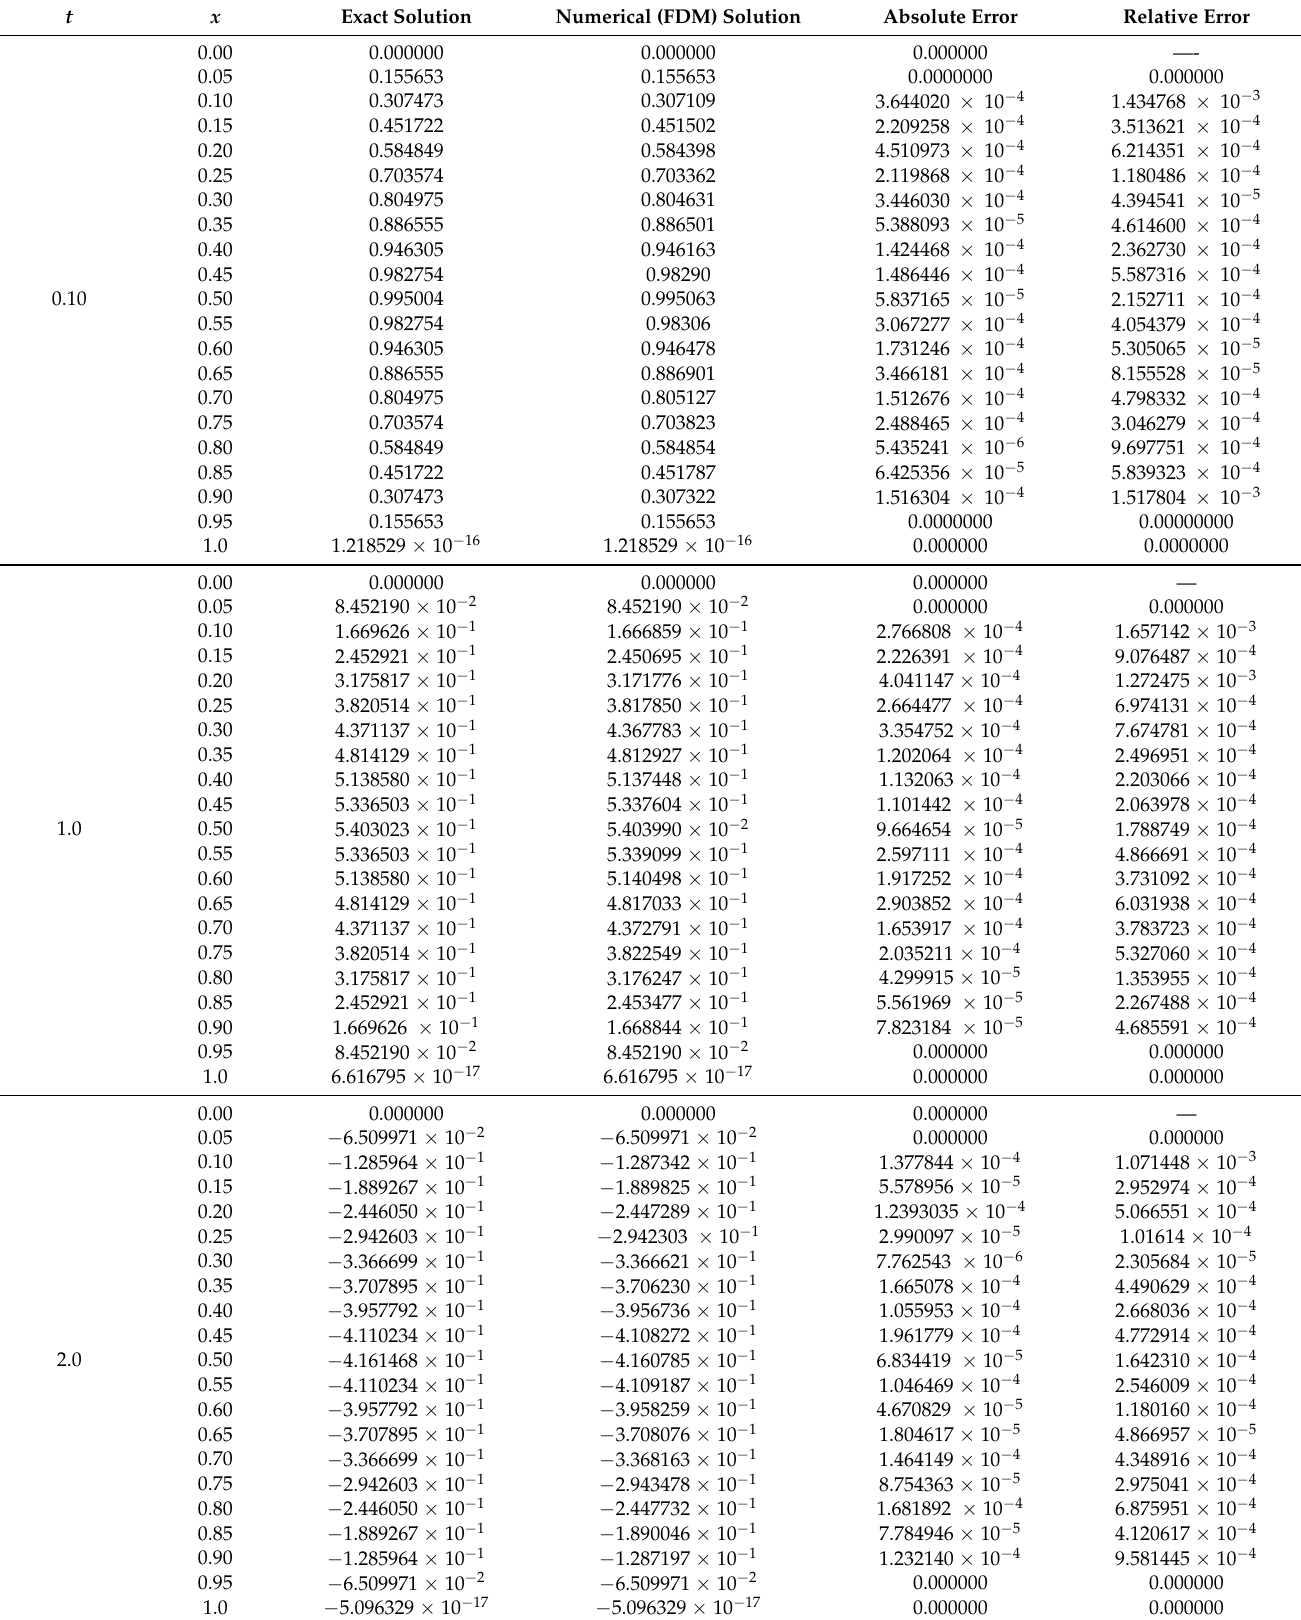
Table 1. Absolute and relative errors at some values of x using a classical finite difference scheme with ∆ t = 10 − 5 , ∆ x = 0.05 at times t = 0.10, 1.0,